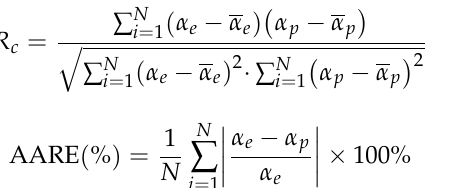
Figure 10. Macroscopic photo of samples after the SSIC at different, ( a ) deformation temperatures, and ( b ) strain rates. The macroscopic photo of the samples processed at the deformation temperature of 630 °C under different strain rates is shown in Figure 10b. It was found that the macro- scopic photo of the compressed sample changed significantly when the strain rate in- creased. The integrity of the compressed sample was relatively high at a relatively small strain rate, while the compressed sample was broken as the strain rate increased. This was